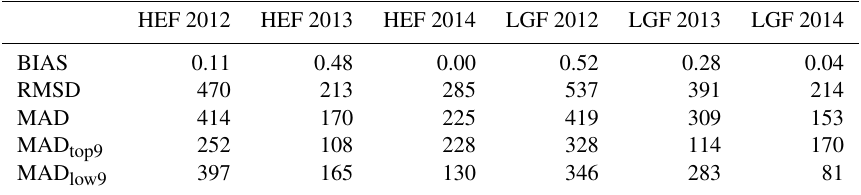
Table 3. Five objective functions are used to analyse the model performance. The minimum value for every function and each year are given in kgm − 2 . While the BIAS is low in all cases, absolute errors and RMSD are much higher, and highest in 2012. Note that the minimum MAD does not refer to the same run over the whole glacier and its upper and lower